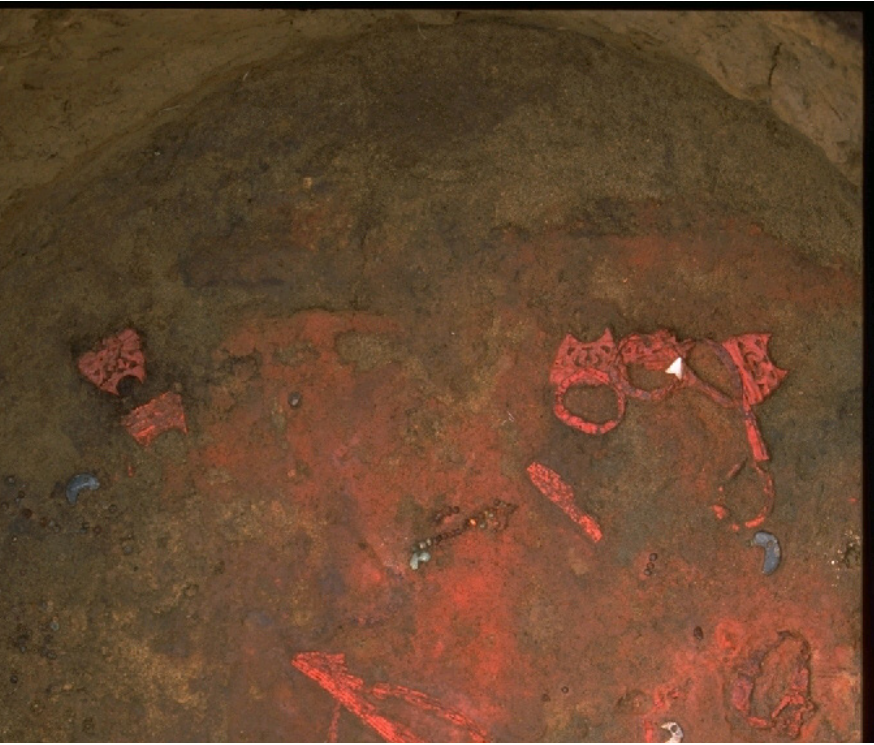
Figure 4. Excavated state of the pit grave no.123 at Karinba site, Hokkaido. Photograph kindly provided by Eniwa City Board of Education with